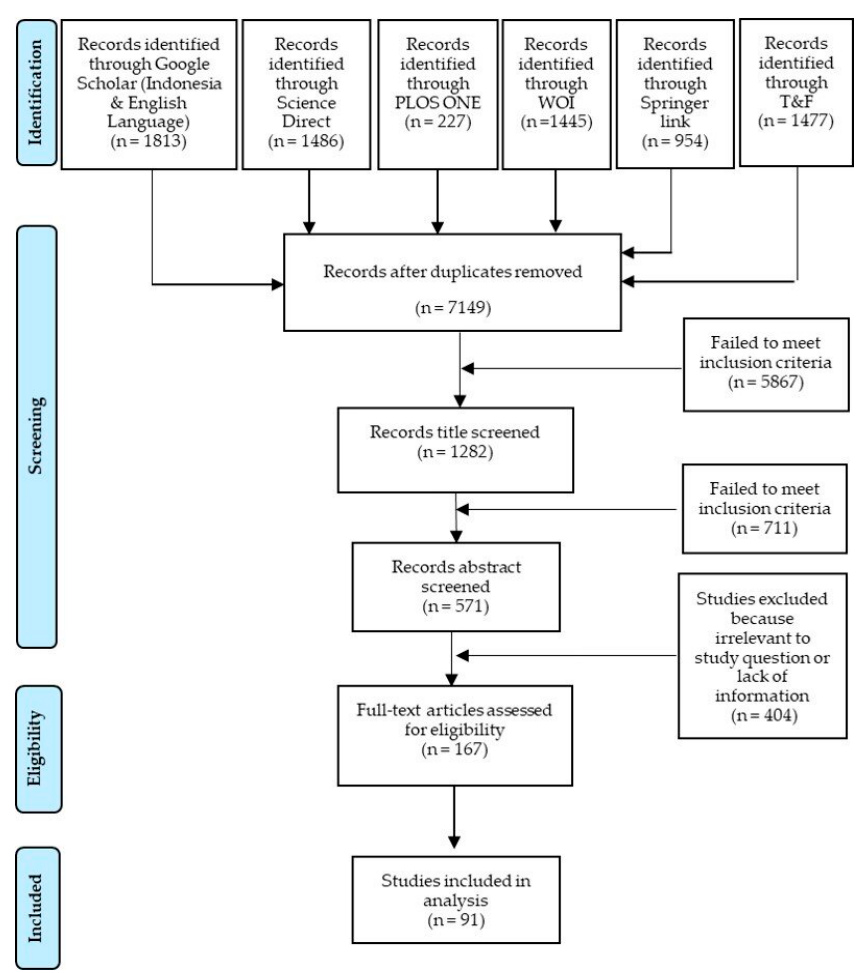
Figure 1. A PRISMA diagram depicting the screening process and quality assessment of each publication.